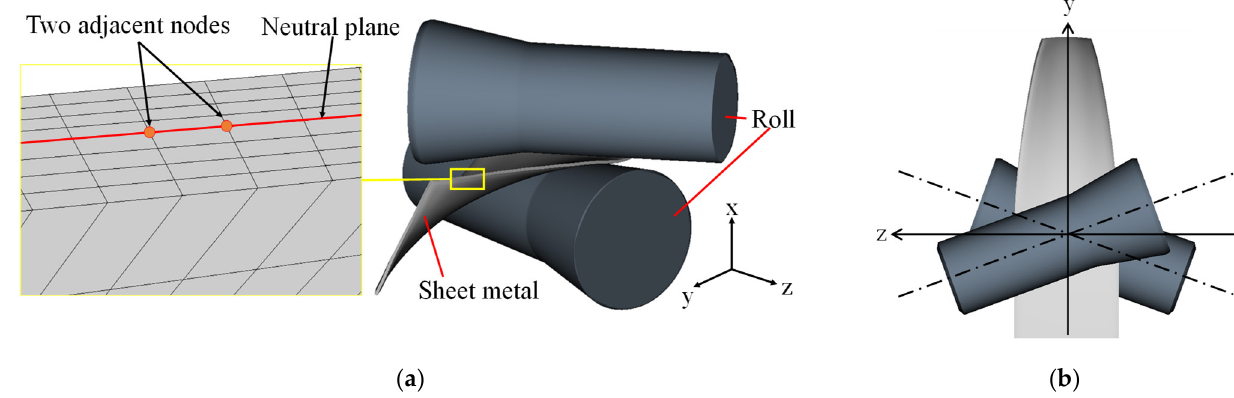
Figure 6. FEA model: ( a ) diagonal view and ( b ) top view.